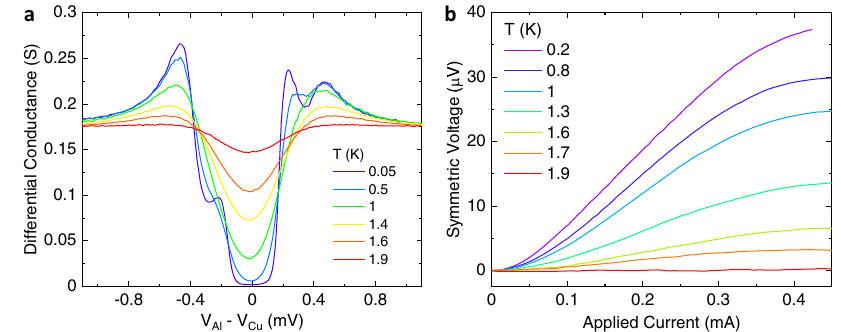
Fig. 4 Temperature dependence of the superconducting recti fi er. a Differential conductance vs. voltage of the junction measured for different temperatures from 50 mK to 1.9 K. b Temperature evolution of the transverse recti fi cation voltage vs. biasing current. Both measurements are performed at B =